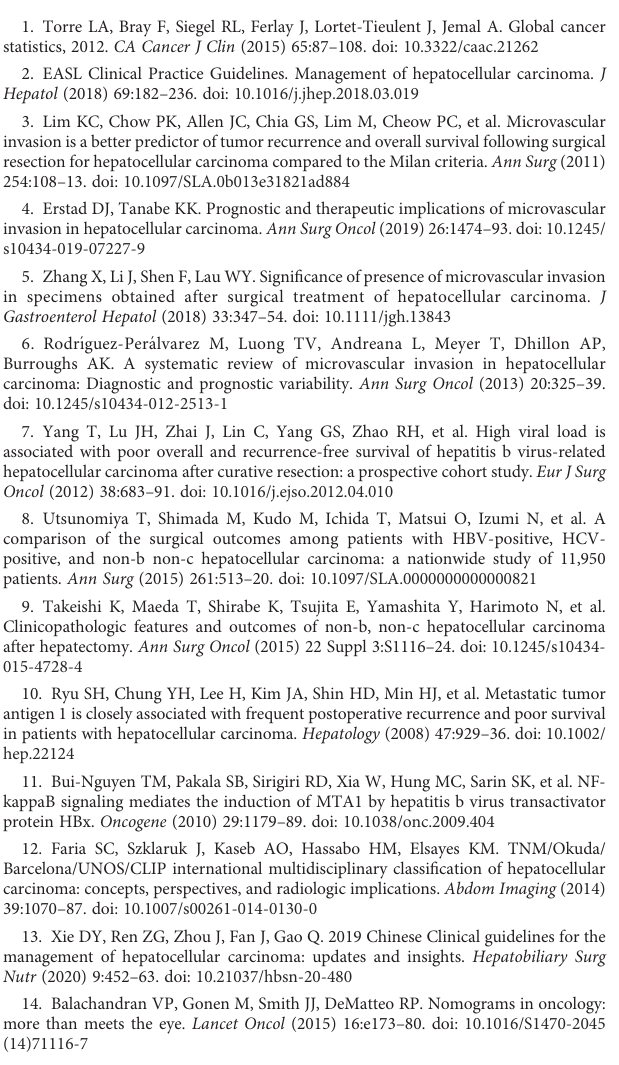
SUPPLEMENTARY FIGURE 1 Flow Chart of patient ’ s inclusion. SUPPLEMENTARY FIGURE 2 Postoperative recurrence (A) and OS (B) in the training and validation